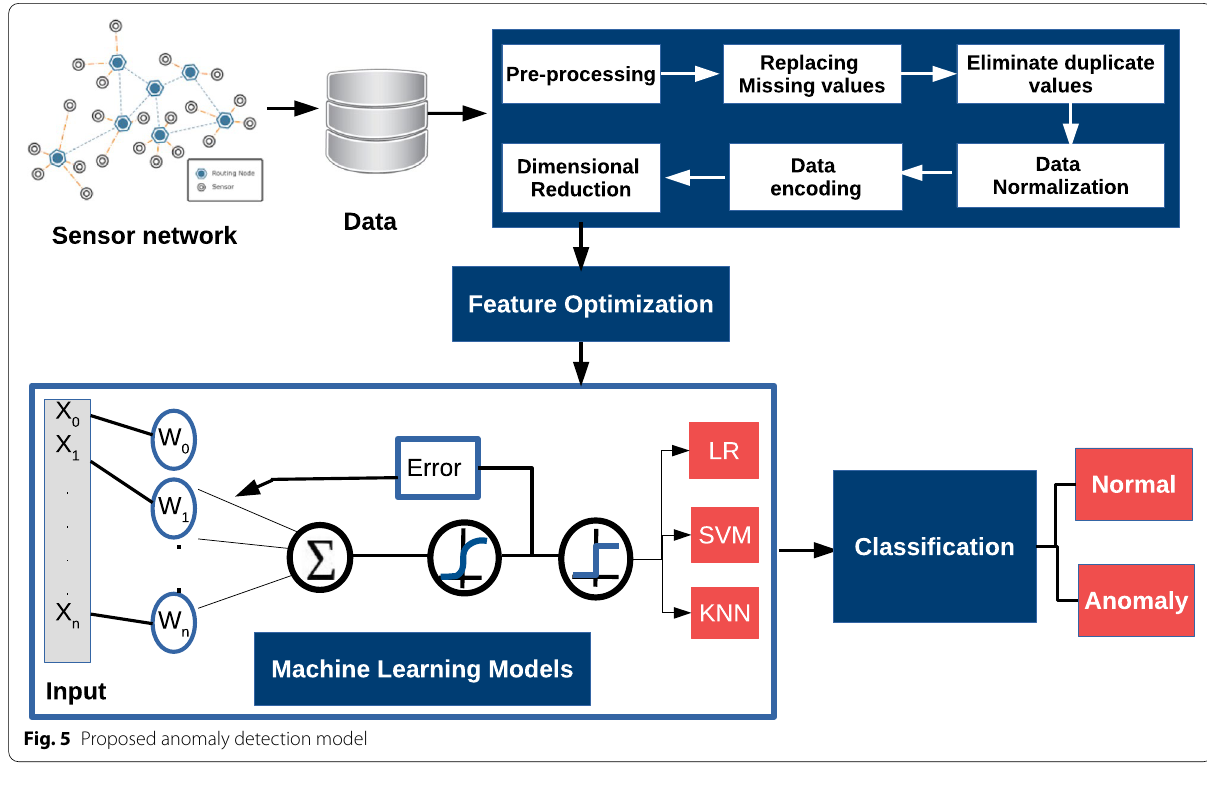
Fig. 5 Proposed anomaly detection model